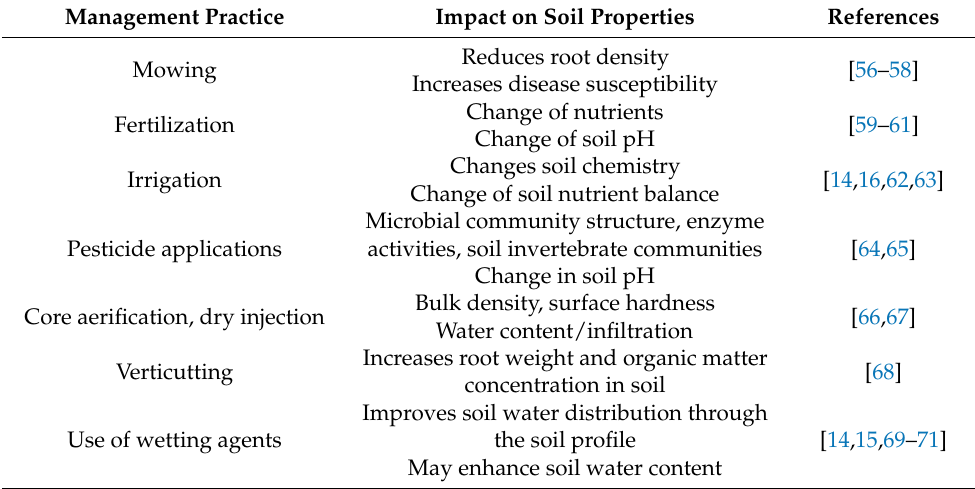
Table 1. Selected publications on the impact of common management practices in the golf industry on soil physicochemical properties and/or plant physiology.